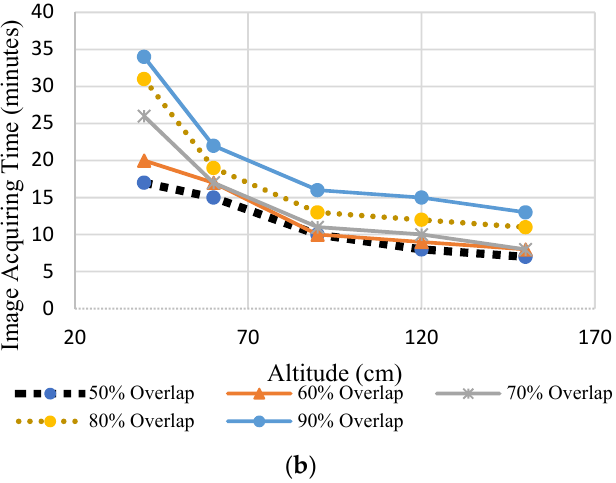
Figure 7. ( a ) Influence of image overlap on image acquisition time; ( b ) influence of altitude on image acquisition time.